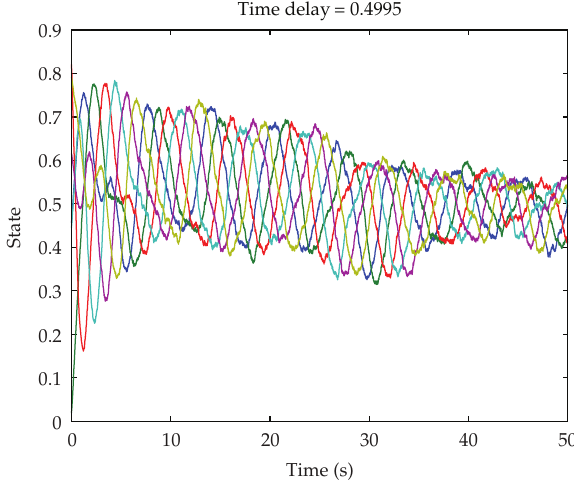
Figure 2: State trajectories under protocol (cid:7) 2.11 (cid:8) and a (cid:7) t (cid:8) (cid:6)